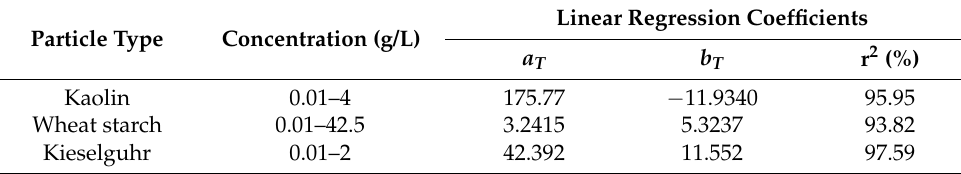
Table 5. Linear regression analysis for the normalized number of photons: N = a T M + b T . Particle Type